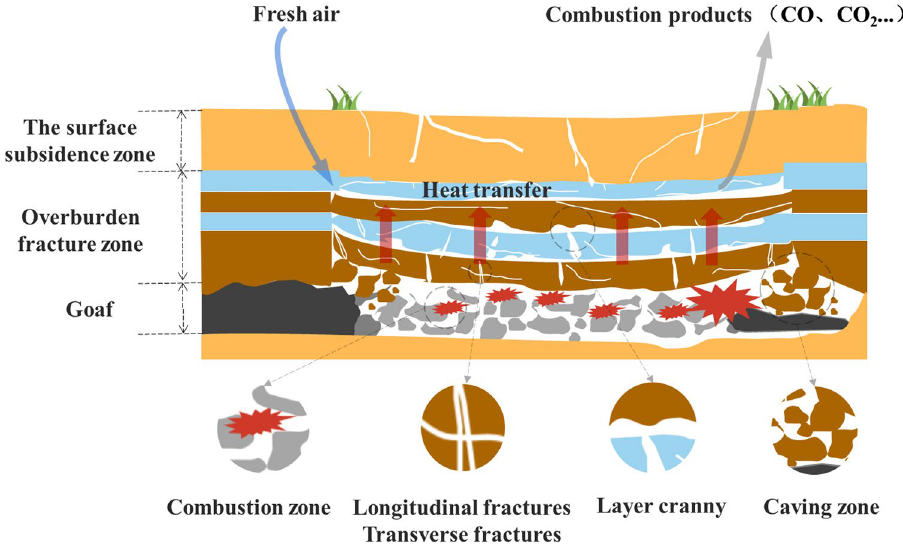
Fig. 6 Formation and